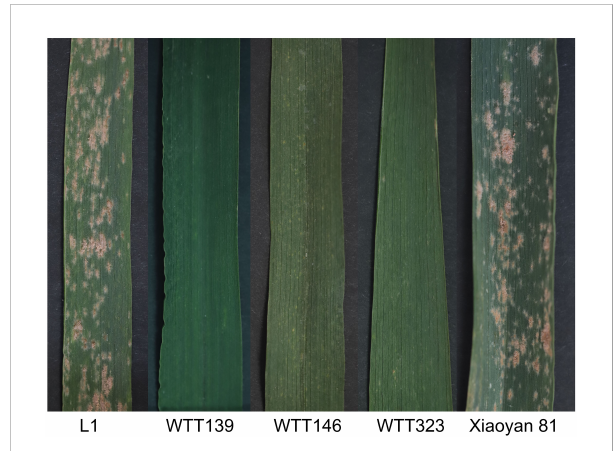
FIGURE 5 The powdery mildew resistance responses of four translocation lines and Xiaoyan 81.